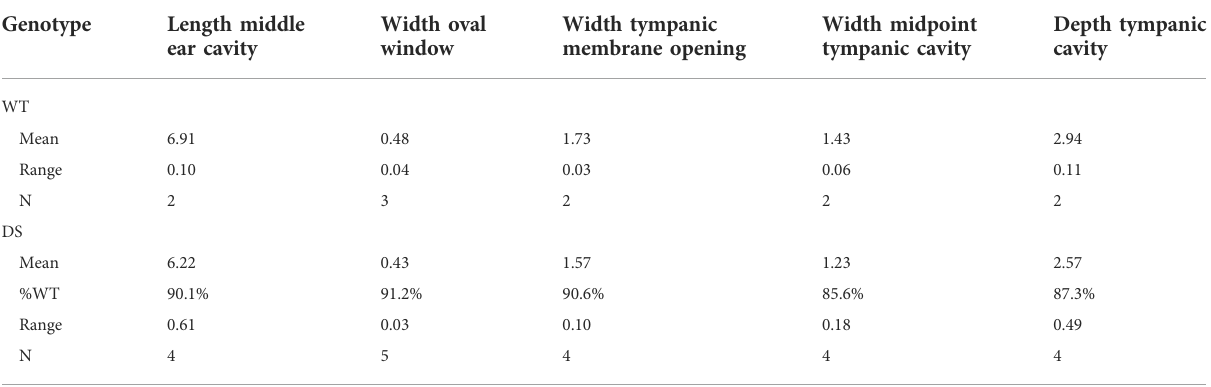
TABLE 1 Dimension of middle ear cavity